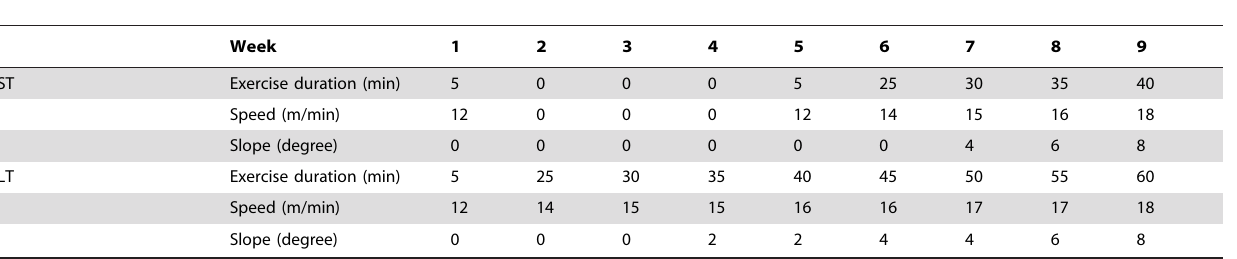
Table 1. Exercise protocol for the short term (ST) and long term (LT) trained groups.